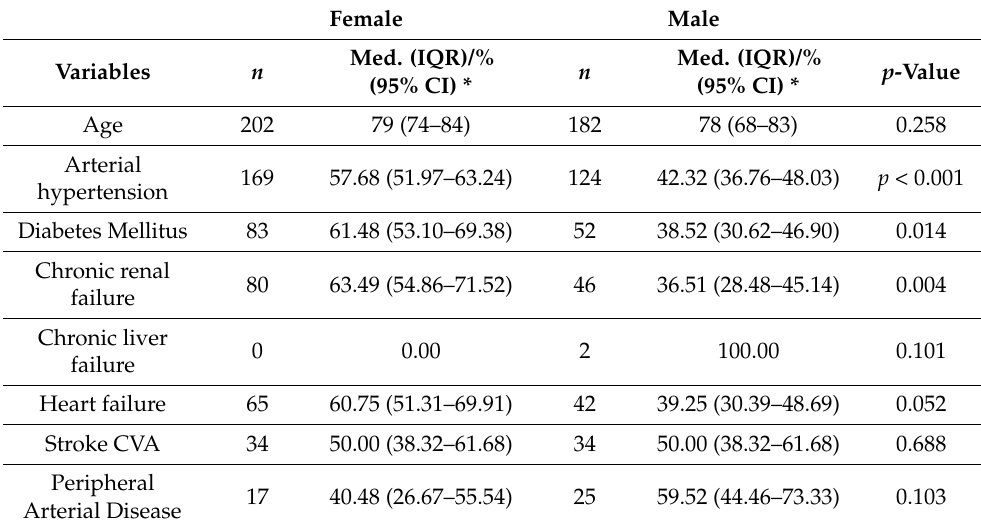
Table 1. Cross-tabulation of variables with